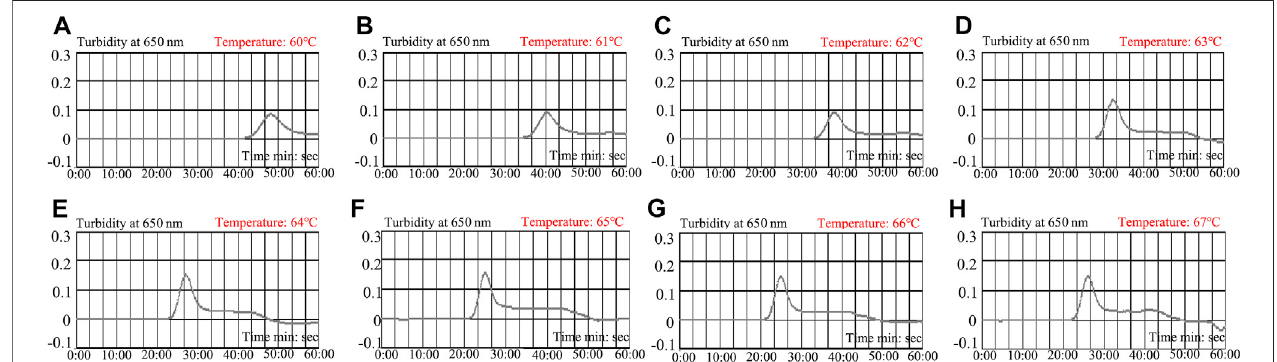
FIGURE 5 | Optimization of ampli fi cation temperature for the HBV-LAMP primer set. The LAMP reactions for the detection of HBV were monitored through real- timeturbidity(LA-500),andthecorresponding curvesofDNAconcentrationsaredisplayed inthegraph.Thethreshold value > 0.1wasconsidered asthepositiveresult. 8 kinetic graphs were obtained at different temperatures (60 – 67 ° C; 1 ° C interval) with 100 IU target genomic DNA per reaction. The graphs from e to h show robust ampli fi cation. The optimal ampli fi cation temperature was 65 ° C.